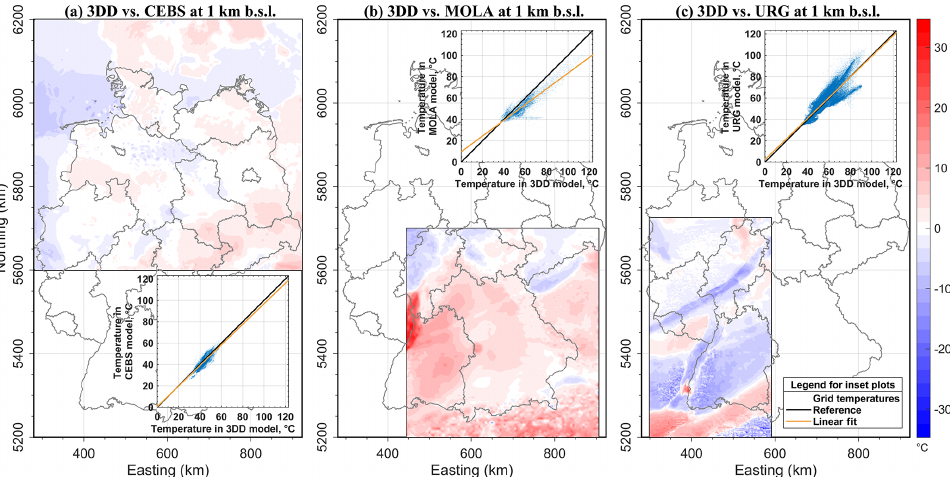
Figure 6. Comparison of thermal field of 3-D-D model at 1kmb.s.l. with (a) CEBS, (b) MOLA, (c) URG in corresponding areas. Colour bar show temperature difference in ◦ C scaled equally in all three panels. Each panel is complemented with a cross-plot of grid temperature values and their linear